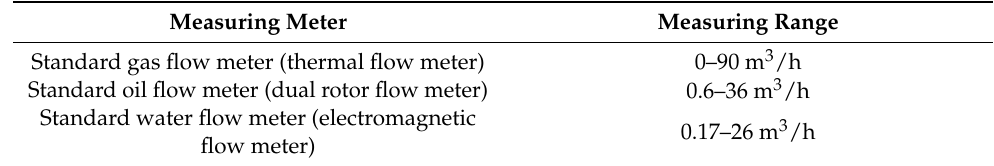
Table 1. Description of standard flow